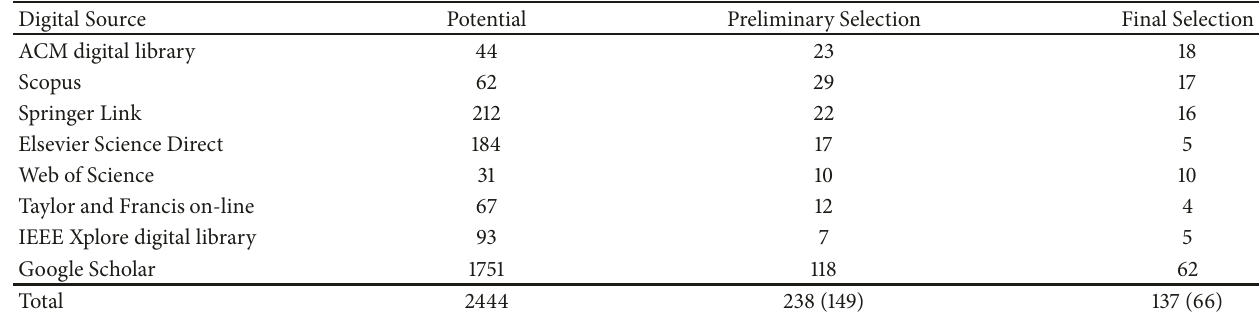
Table 5: Digital search results resulting from applying the search string to the selected digital libraries. The numbers in parentheses show the number of unique